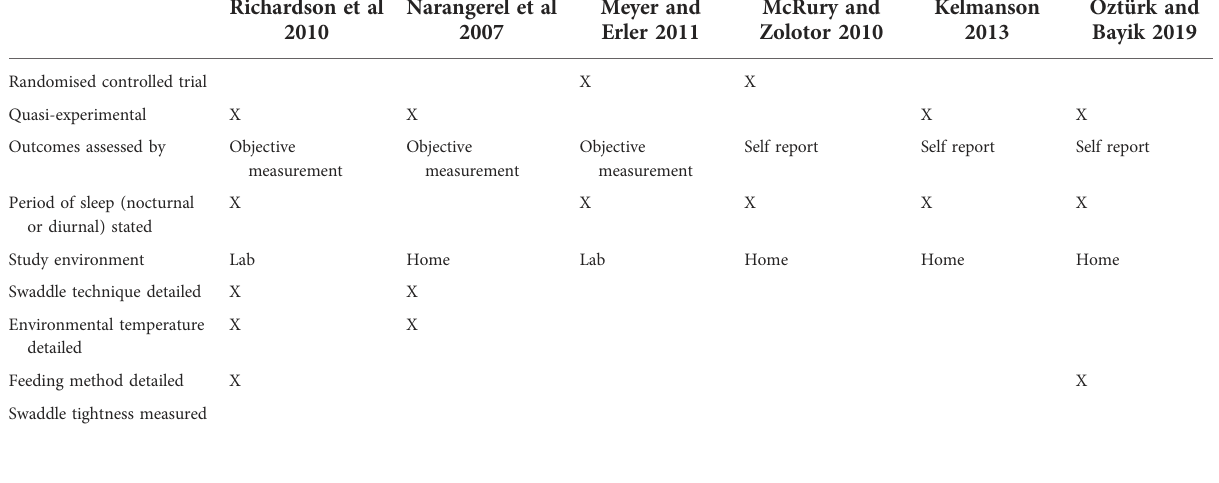
TABLE 2 Summary of study designs and key